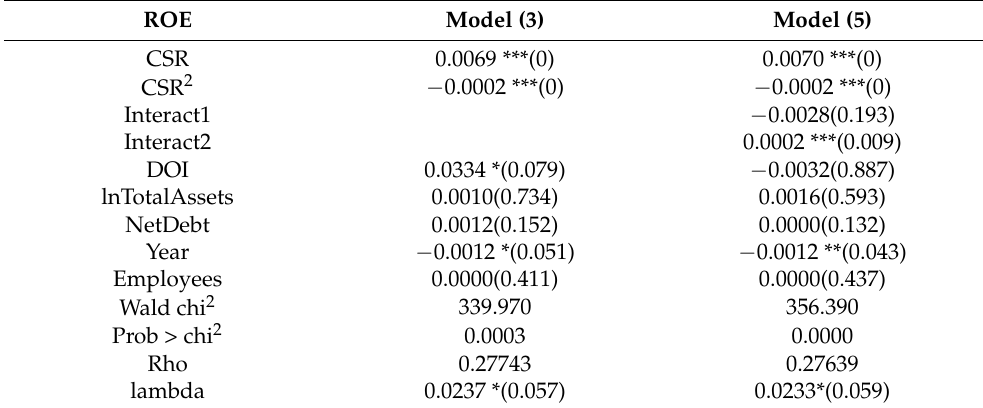
Table 6. Robustness test